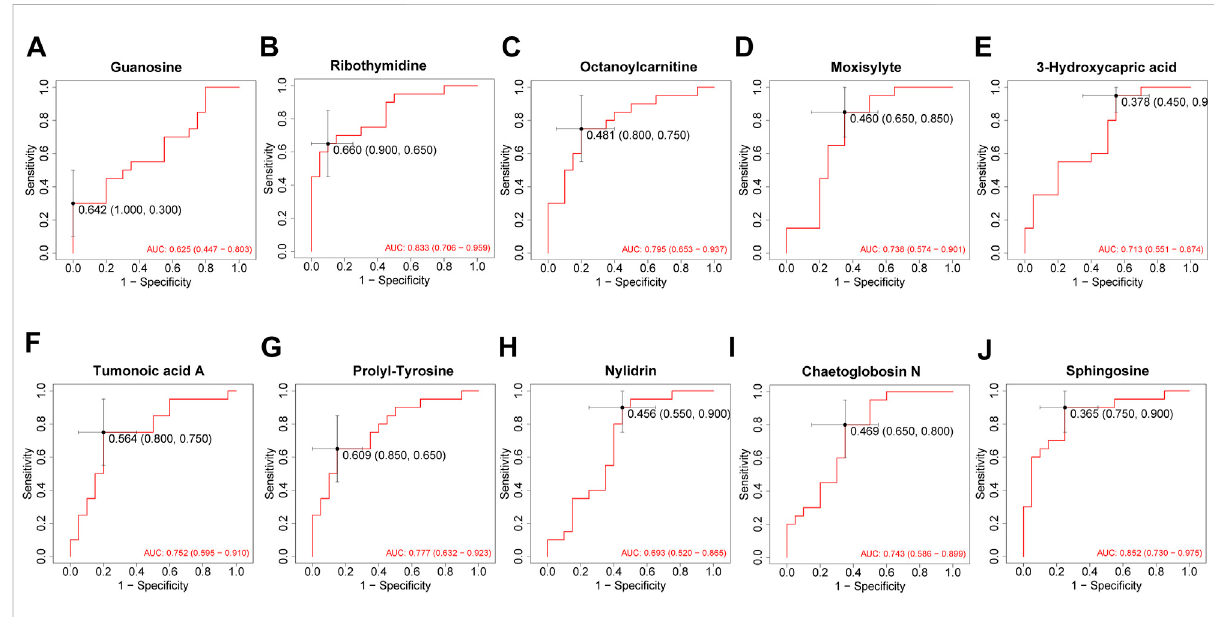
FIGURE 4 ROCanalysisoftop10mostdiscriminantmetabolites (A – J) fordistinguishingSSNHLpatientsandHCs.ROC:receiveroperatingcharacteristics; SSNHL, sudden sensorineural hearing loss; HC, healthy control.